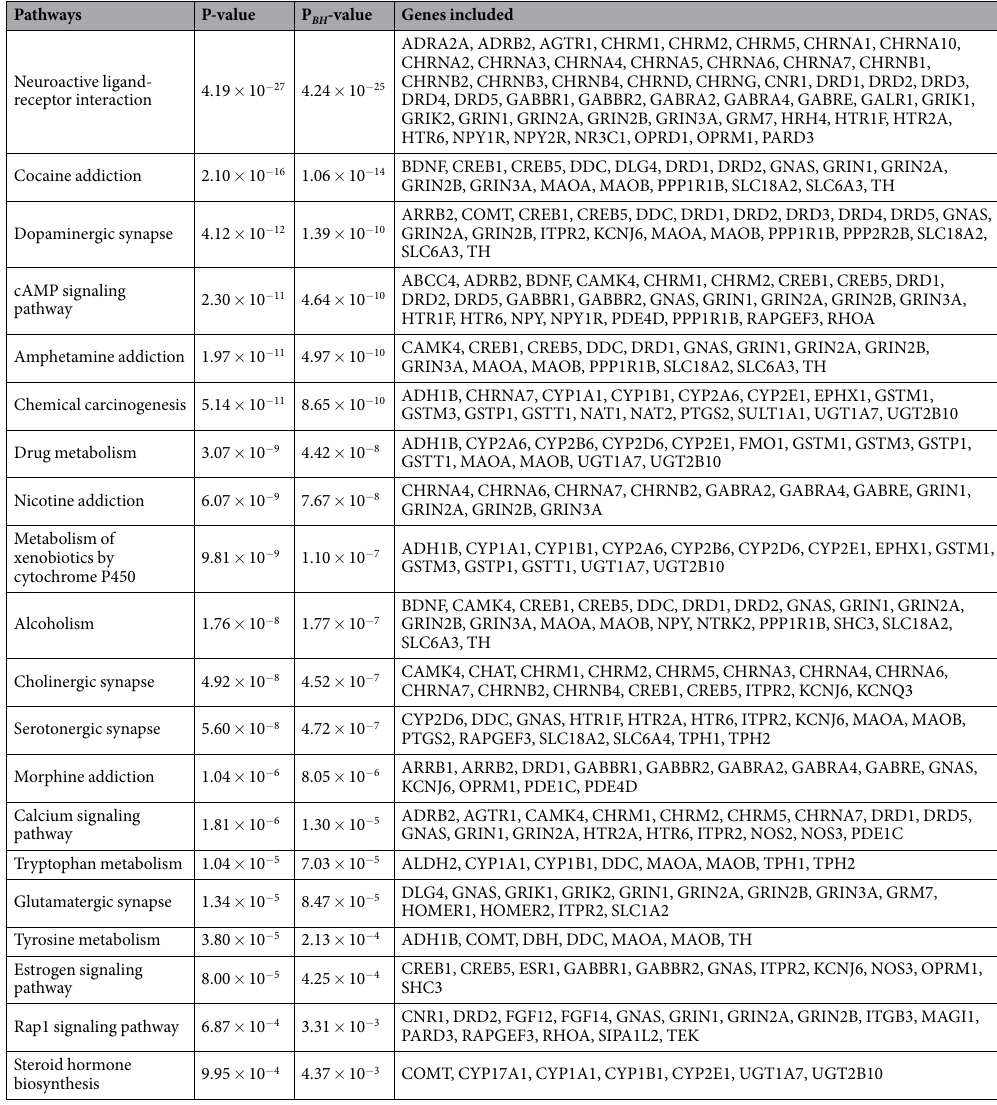
For SCZgenes, 23 significantly enriched pathways were identified (Table 2). Similar to NAgenes, most of these pathways were closely related to neuronal functions. Pathways of dopaminergic synapse, glutamatergic synapse and serotonergic synapse were identified, which were in agreement with the dopamine hypothesis 41 , glu- tamate hypothesis 42 , and serotonergic hypothesis 43 of schizophrenia. In addition, signaling transduction-related pathways, such as calcium signaling pathway, GABAergic synapse and gap junction, long-term depression, cAMP-mediated signaling, T cell receptor signaling pathway, circadian entrainment, and MAPK signaling path- way were also identified. Furthermore, 5 pathways including cocaine addiction, alcoholism, amphetamine addic- tion, nicotine addiction, and morphine addiction were enriched in SCZgenes, implying that the pathways related to drug addiction may play important roles in the origin and development of schizophrenia. Comparing the pathways associated with the two diseases, there were 8 pathways specific to nicotine addic- tion, 11 pathways specific to schizophrenia, and 12 shared pathways. These shared pathways include pathways related to synapse function and signaling transduction (i.e., neuroactive ligand-receptor interaction, dopamin- ergic synapse, calcium signaling pathway, cAMP signaling pathway, glutamatergic synapse and serotonergic syn- apse) and pathways related to drug addiction (i.e., nicotine addiction, cocaine addiction, morphine addiction, amphetamine addiction, and alcoholism). This implies that the drug addiction-associated pathways may play an essential role in both nicotine addiction and schizophrenia. Some pathways were only significantly enriched in genes associated with one of the two diseases, but they also included genes involved in the other disorder. For example, retrograde endocannabinoid signaling, a pathway mainly consisting of neuromodulatory endocan- nabinoids and their receptors, and playing important role in mediating global modulation of synaptic strength, localized short-term associative plasticity and cerebellar long term depression, was identified as enriched pathway for schizophrenia. A close inspection showed that for 20 genes included in this pathway, 12 genes were related